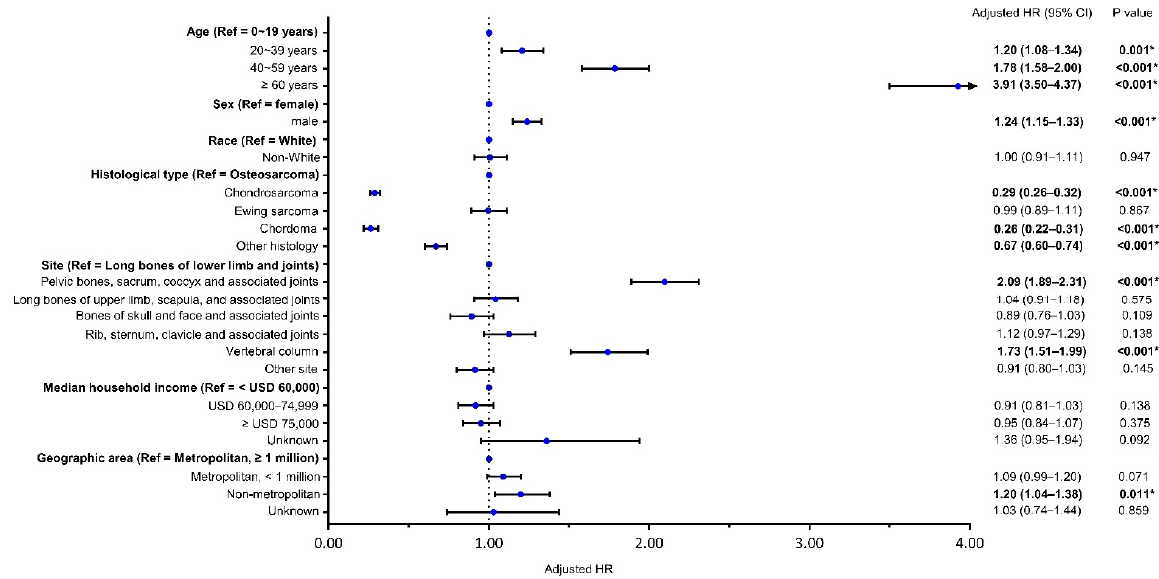
Figure 1. Forest map showing the independent risk factors of CSM. CSM: bone sarcomas-specific mortality; HR: hazard ratio; CI: confidence interval * Statistically significant. Bolds indicated reference variable or statistically significant.